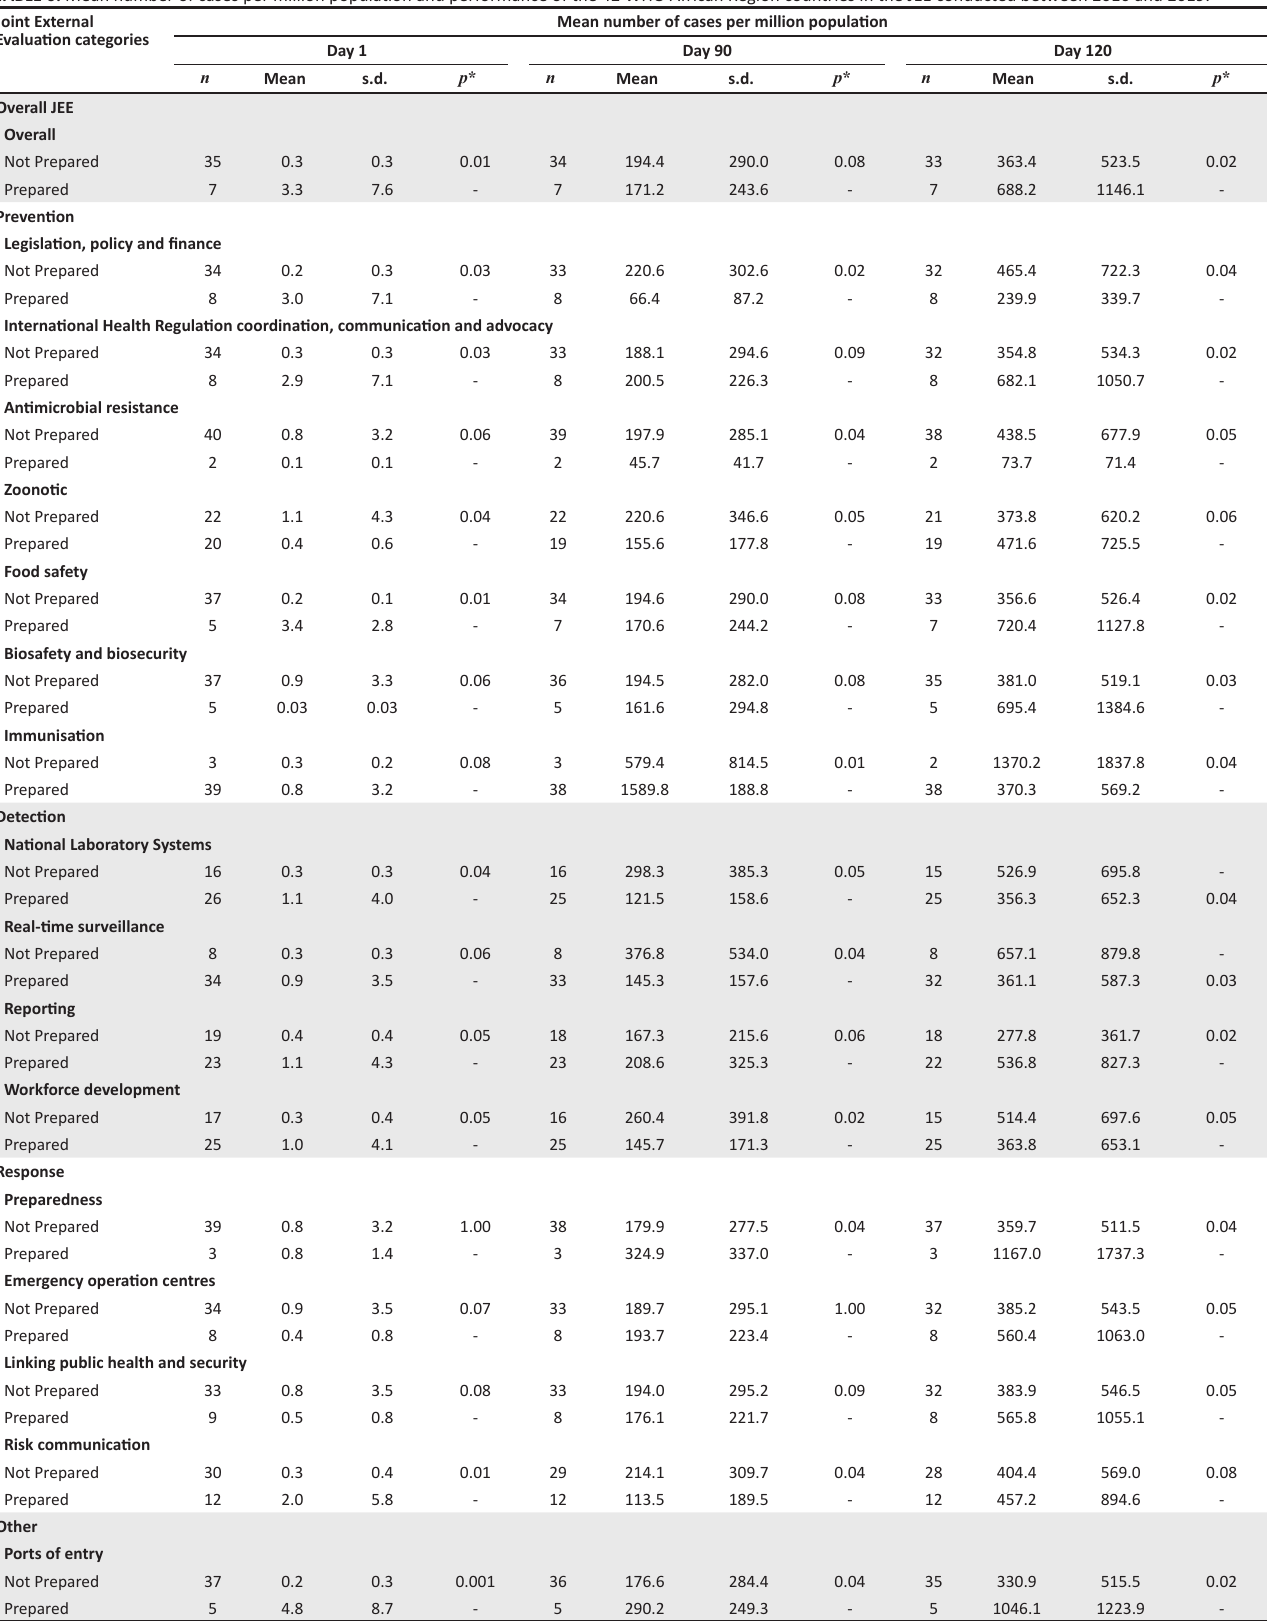
Mean number of cases per million